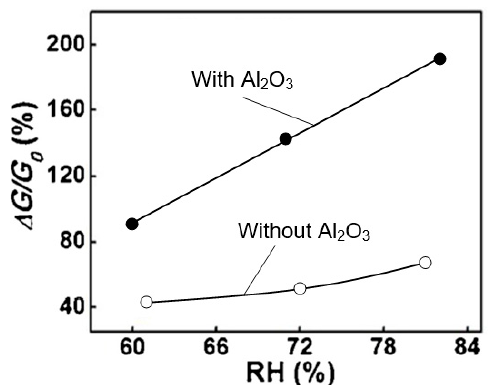
Figure 20. Conductivity response of the BP humidity sensors without and with Al 2 O 3 layer as a function of RH levels. Reproduced with permission from Ref. [125]. Copyright American Chemical Society, 2017.